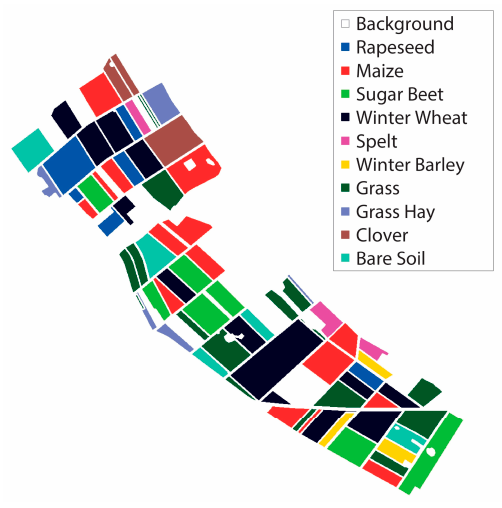
Figure 2. Reference map for all crop